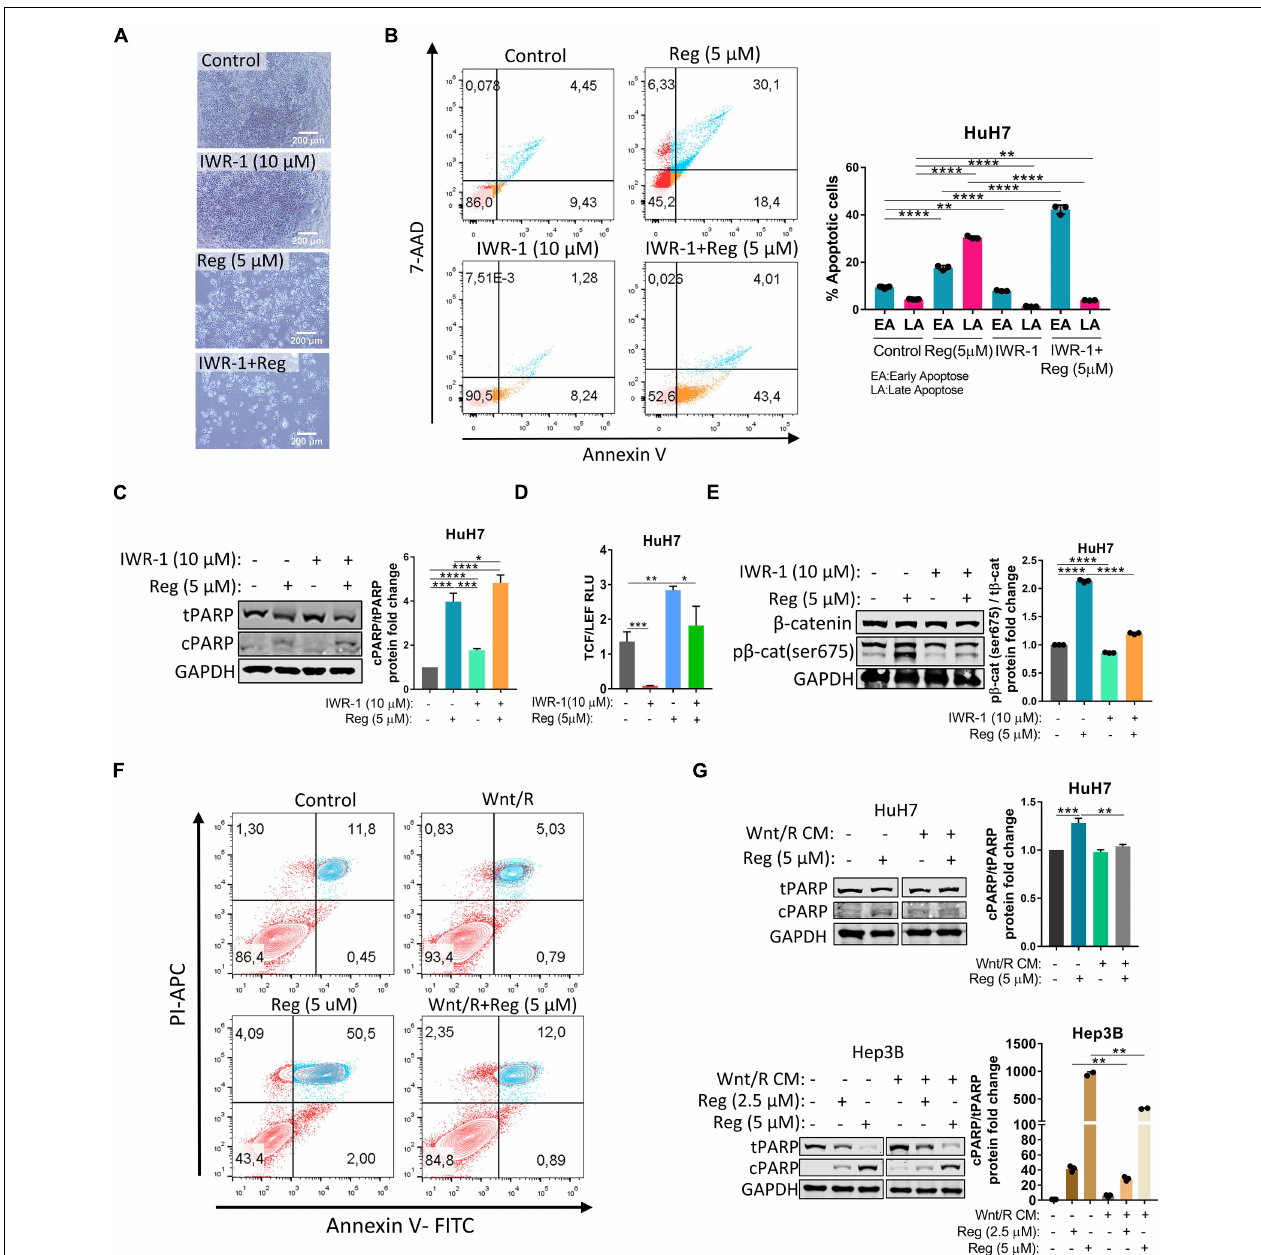
FIGURE 2 | Wnt/ β -catenin activation via Wnt3a/R-Spo1 treatment protects cells from regorafenib induced apoptosis while Wnt/ β -catenin inhibition by IWR-1 augments cell death upon regorafenib treatment. (A) Light microscope images indicate augmented cell death upon regorafenib and IWR-1 treatment. Scale bar: 200 µ M (B) Apoptosis rates of HuH7 cells treated with IWR-1, regorafenib or their combinations were analyzed by Annexin V/PI staining using flow cytometry. (C) Western blot analysis of c-PARP and t-PARP in treated cells. (D) IWR-1 suppresses basal and regorafenib induced TCF/LEF reporter activity in the HuH7 cell line. (E) IWR-1 suppresses basal and regorafenib induced p- β -catenin expression in the HuH7 cell line (F) Apoptosis rates of HuH7 cells treated with Wnt3a/R-Spo1, regorafenib or their combinations were analyzed by Annexin V/PI staining using flow cytometry. (G) Western blot analysis of c-PARP and t-PARP in treated cells. Data represent the average of at least three independent experiments. p > 0.05 (n.s.), p ≤ 0.05 (*), p ≤ 0.01 (**), p ≤ 0.001 (***), p ≤ 0.0001 (****). Error bars indicate standard deviation (SD).